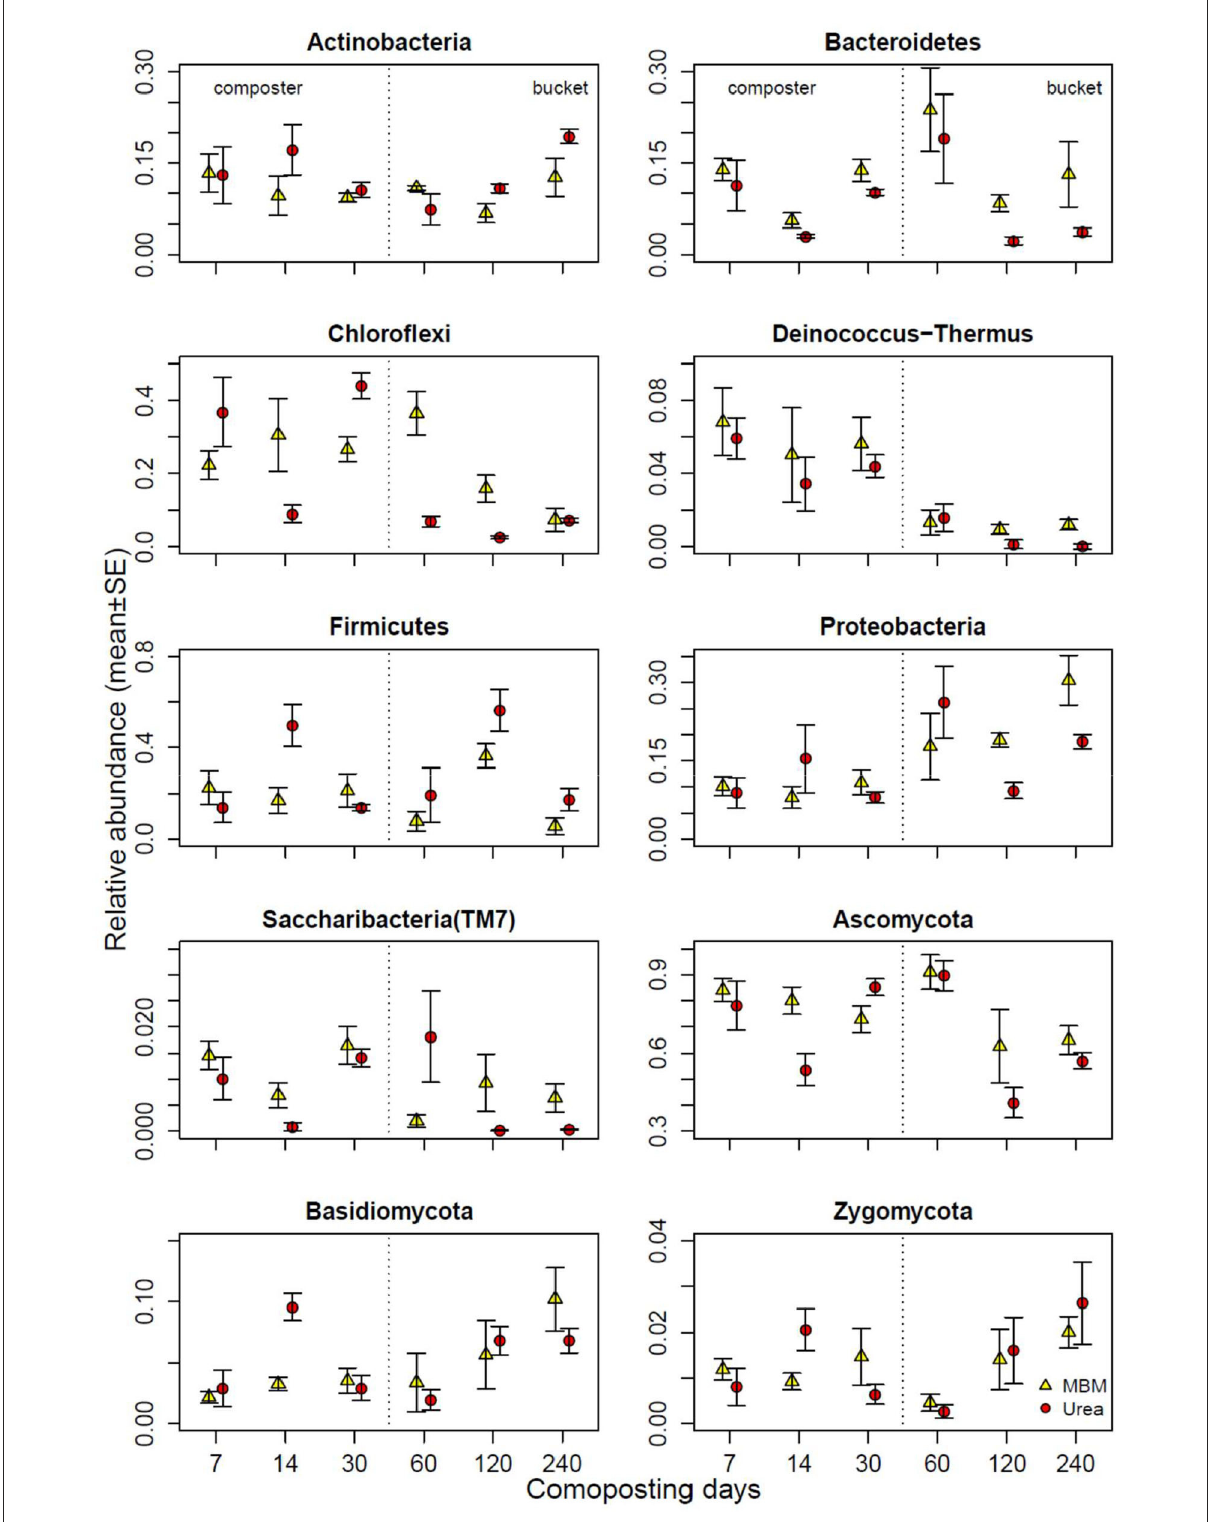
FIGURE5 Relative abundances of bacterial and fungal phyla in compost of meat and bone meal (MBM) and urea treatments (urea) and time (X axis). Error bars represent standard